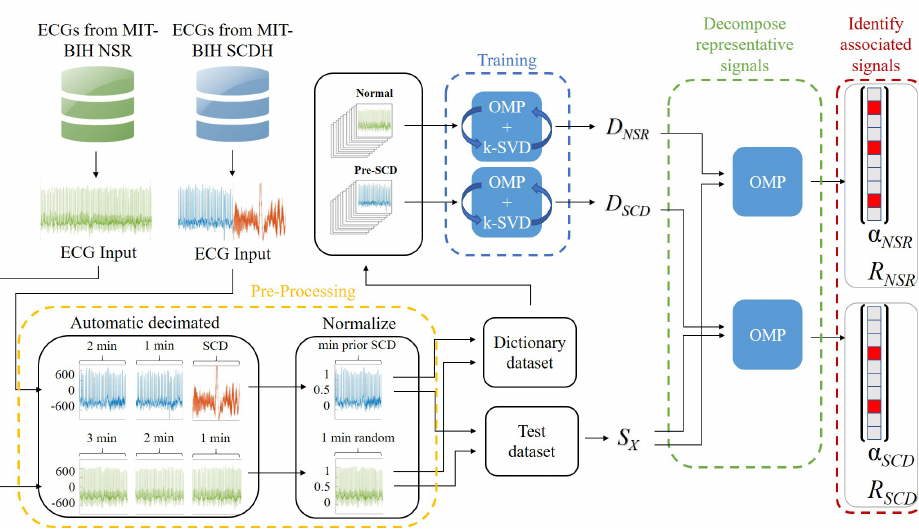
Figure 1. Framework for ECG signal analysis: pre-processing step to obtain 1 min intervals from normal and SCD signals (yellow block), a training step for recognizing particular features from the intervals of interest (blue block), and identification of test signals through their decomposition by sparse representations (red block). In this approach, vector α is considered the feature